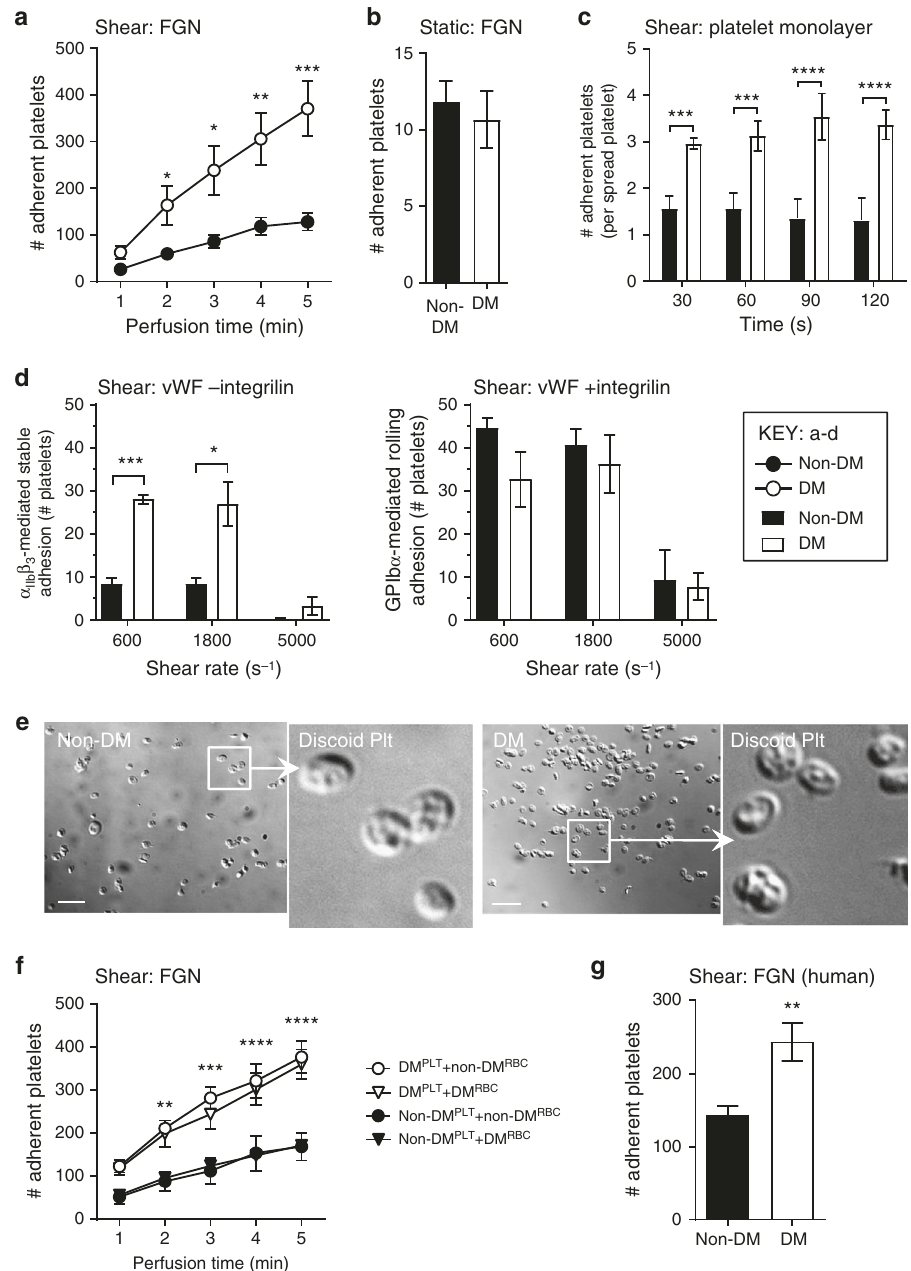
Fig. 3 Diabetes enhances integrin α IIb β 3 mediated platelet adhesion under shear. a Hirudinated whole blood from non-DM or DM mice were perfused through fi brinogen (FGN) matrices for 5 min at 600 s − 1 , and the number of adherent platelets determined at the indicated perfusion times. b Isolated mouse platelets were allowed to adhere to FGN matrices under static conditions for 5 min, and the number of adherent platelets quantitated. c Hirudinated whole blood from non-DM and DM mice were pretreated with ampli fi cation loop blockers (ALBs): indomethacin (10 μ M), MRS2179 (100 μ M), and 2- MeSAMP (10 μ M), then perfused over spread platelets at 1800 s − 1 . The number of adherent platelets per spread platelet was quanti fi ed at 30 s intervals for 120 s. d Hirudinated mouse whole blood was perfused over mouse vWF matrices at 600, 1800, and 5000s − 1 , as detailed under Methods section. The numbers of stationary ( − integrilin) vs. transient/rolling ( + integrilin) platelets were determined at 1 min perfusion time. e Hirudinated mouse whole blood was perfused through FGN matrices at 600 s − 1 for 1 min, and adherent platelets were fi xed immediately. Representative DIC images depict the discoid morphology of the adherent non-DM and DM mouse platelets. Scale bars = 5 μ m. f Platelets isolated from non-DM and DM mice were reconstituted with isolated red blood cells (RBCs) from the same (autologous) or counterpart (heterologous) mice, prior to perfusion over matrices at 600 s − 1 . The number of adherent non-DM and DM platelets was determined at the indicated perfusion times. g Hirudinated whole blood from non-DM or DM humans was perfused through FGN matrices for 5 min at 300 s − 1 , and the number of adherent platelets determined at 5 min perfusion time. Results performed with human samples are expressed as mean ± s.e.m. of n = 16 for non-DM and n = 18 for DM patients. All other results represent n = 3 mice, with each perfusion performed in duplicates or triplicates. NS = not signi fi cant, p ≥ 0.05; * p < 0.05; ** p < 0.01; *** p < 0.001; **** p < 0.0001, assessed by unpaired, two-tailed Student ’ s t